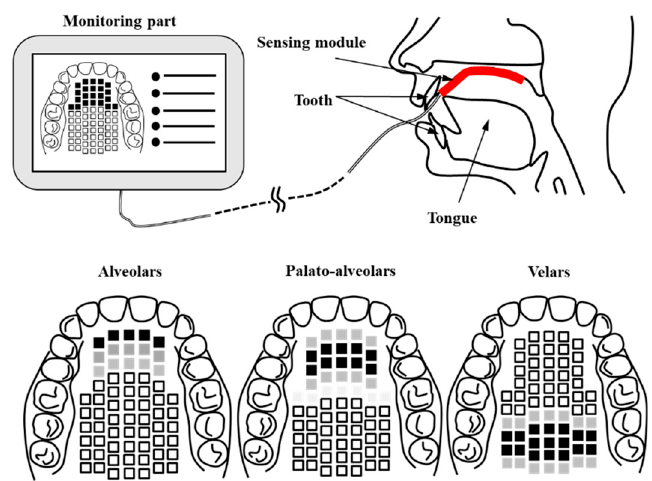
Figure 1. Schematic of the proposed Korean-electropalatography (EPG) system and the position of the tongue.